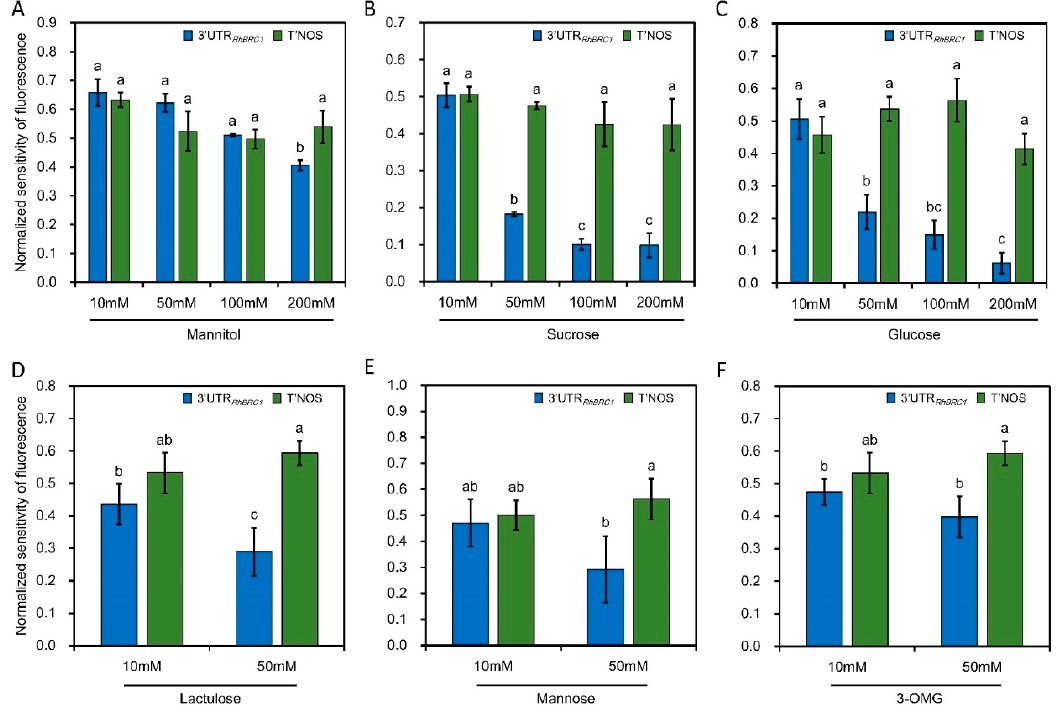
(cid:48) UTR Figure 2. Levels of 3 ′ UTR RhBRC1 -transformed calluses (P35S:GFP::3 ′ UTR RhBRC1 ) as compared to T’NOS- Figure 2. Levels of 3 RhBRC1 -transformed calluses (P35S:GFP::3